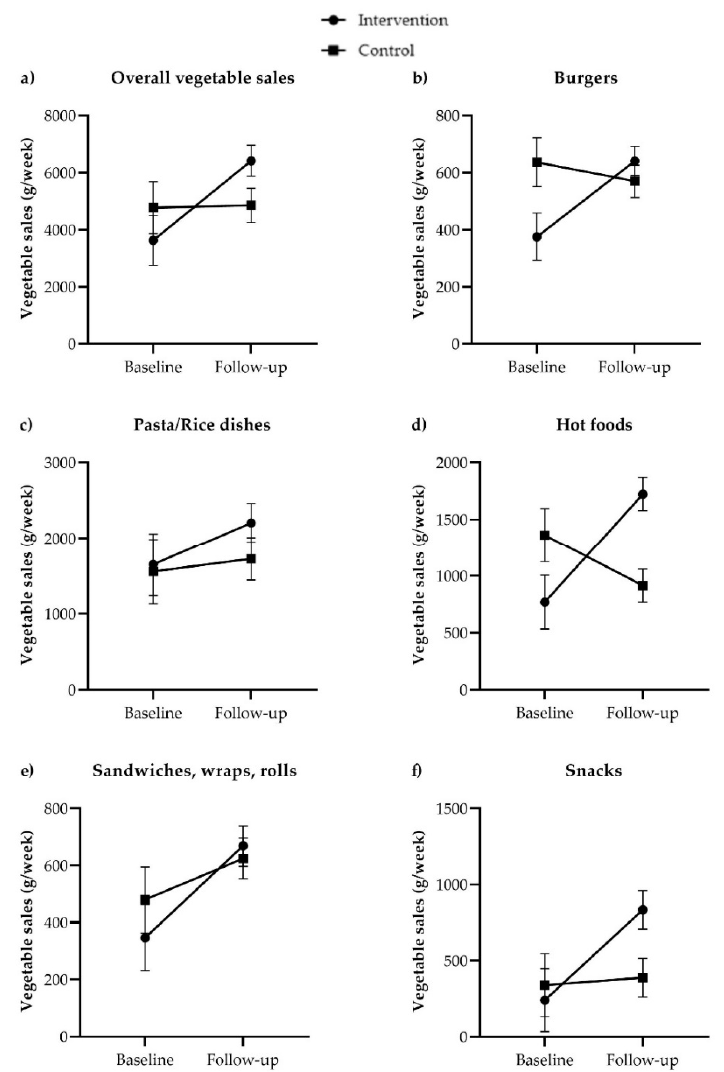
Figure 1. Estimated mean values with standard error of the mean (SEM) on baseline and follow-up in the intervention group ( ) and in the control group ( ) for overall vegetable sales ( a ), and vegetable sales per menu subcategory ( b – f ) in grams of vegetables/week based on the linear mixed models.